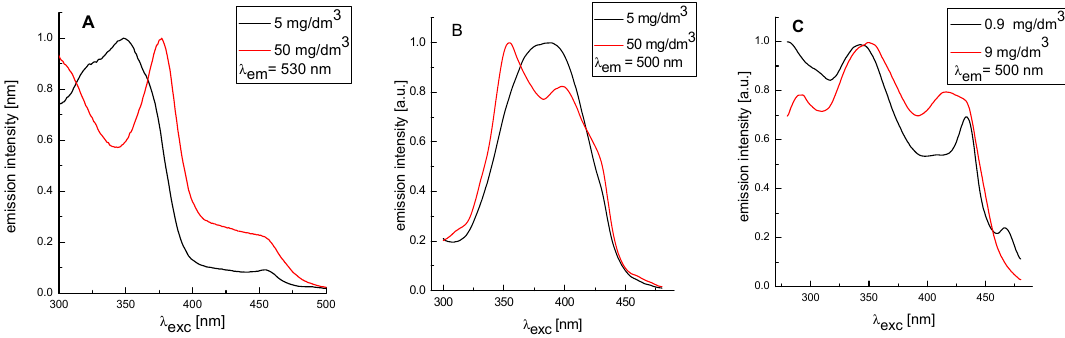
Figure 3. Fluorescence excitation spectra of studied (Hydroxyphenyliminomethyl)phenols: 5 ( A ); 14 ( B ) and 15 ( C ) in methanol at concentration of 0.9 mg/dm 3 . The excitation and emission slits were 2 resp. 10 nm.